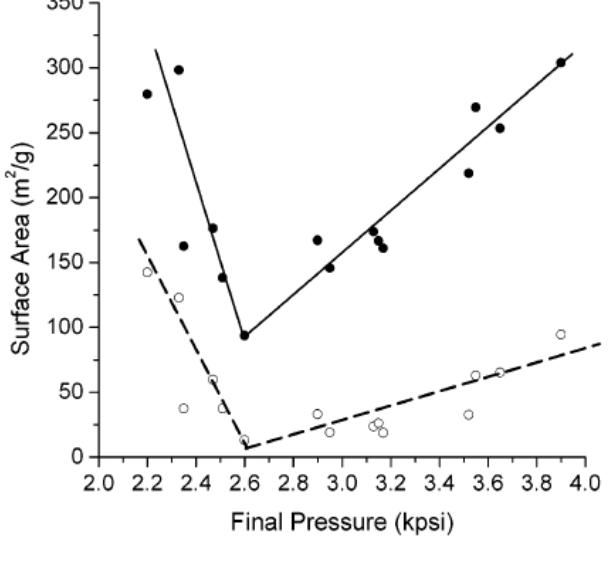
Figure 7. Variation in the total BET surface area ( ● ) and micropore surface area ( о ) of trimethylolpropane trimethacrylate as a function of the CO (adapted) with permission from [30]. Copyright 2004 American Chemical